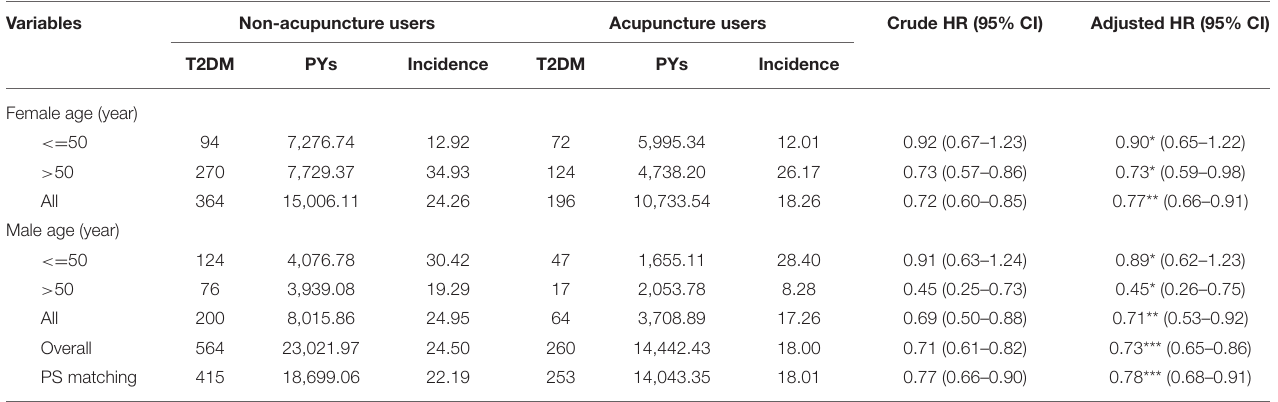
TABLE 2 | Overall age- and sex-specific incidence and adjusted HR of T2DM in relation to acupuncture treatment among RA patients. Variables